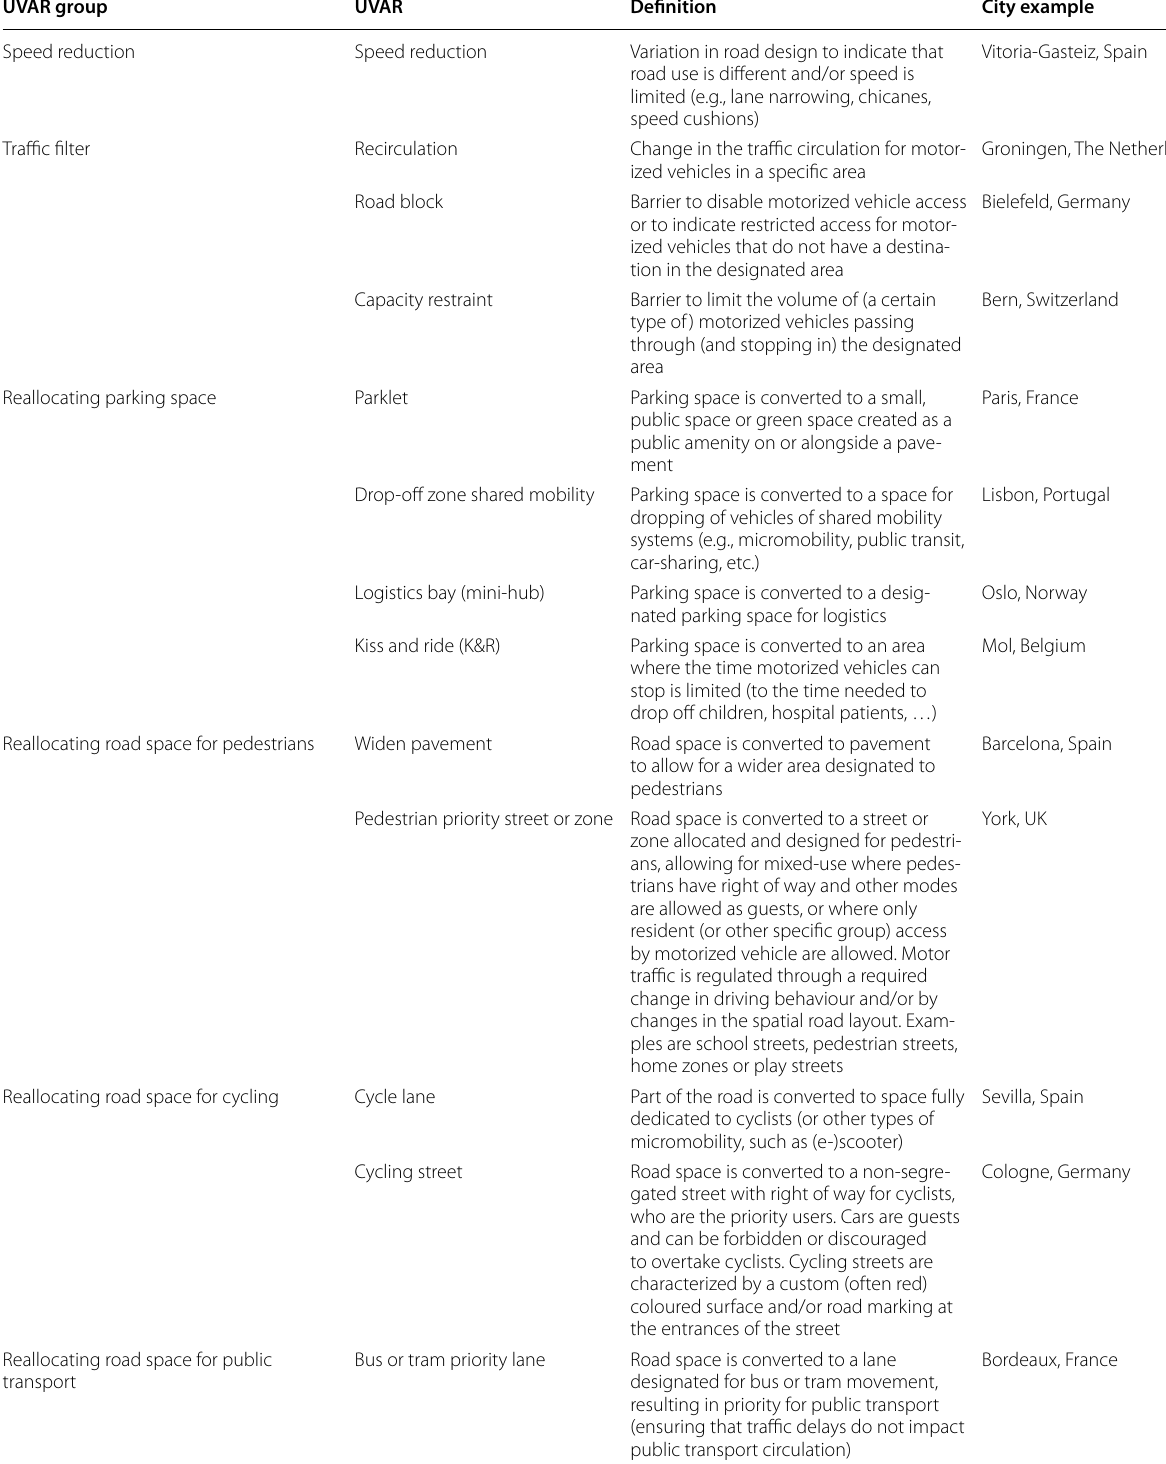
Table 2 UVAR for the spatial interventions category, showing the overarching group, definition and a city example where the measure is